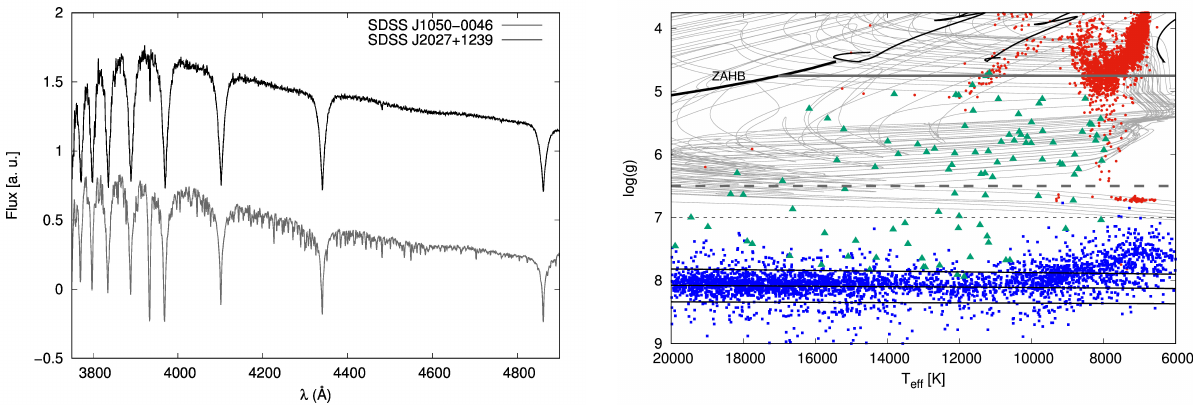
Figure 1. Two sdA stars, SDSS J105025.94-004655.5 (bottom) and SDSS J202721.77+123942.7 (top). While SDSS J1050-0046 shows lots of metallic lines, SDSS J2027+1239 appears to have only a small amount of Ca and Mg.